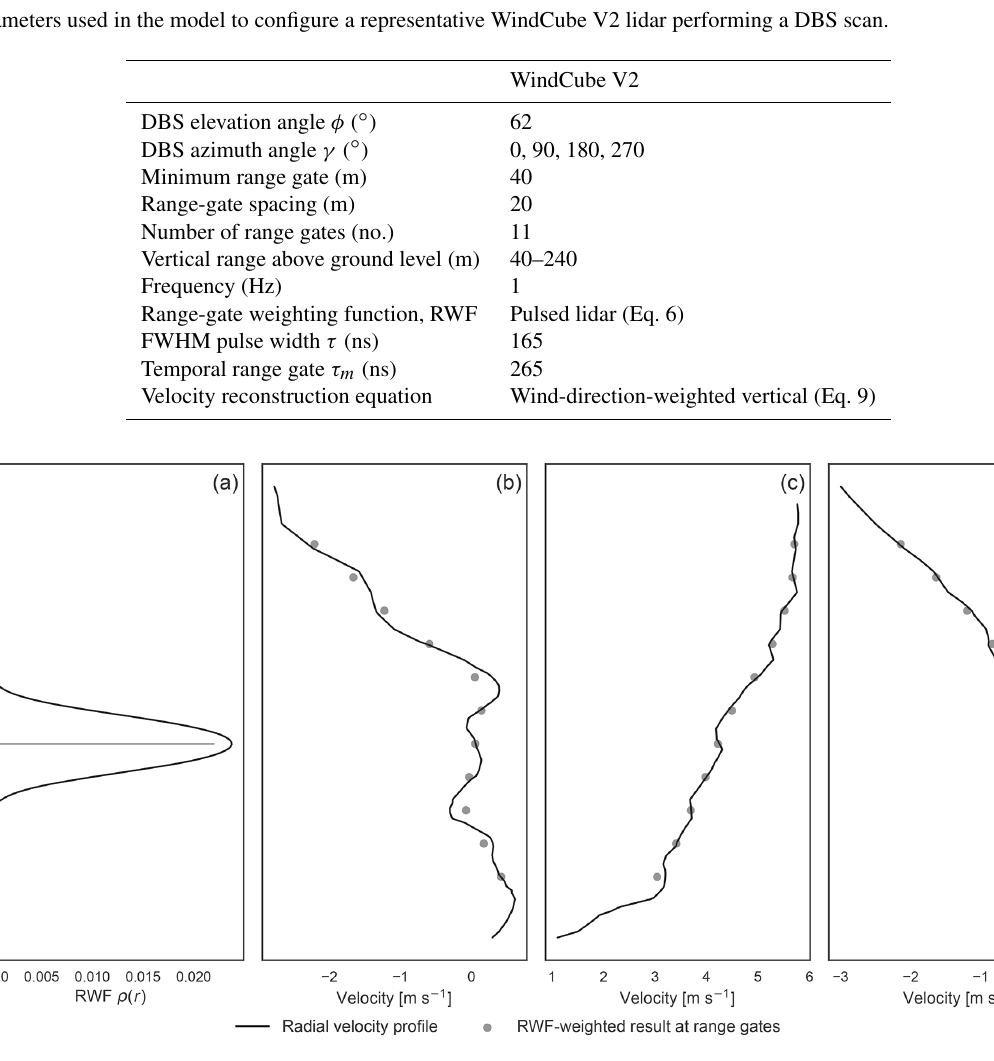
Figure 2. (a) WindCube V2 RWF centered at the 120m range gate and examples (b, c, d) of unweighted radial velocity profiles, interpolated from instantaneous LES winds, compared to the corresponding weighted result at the range